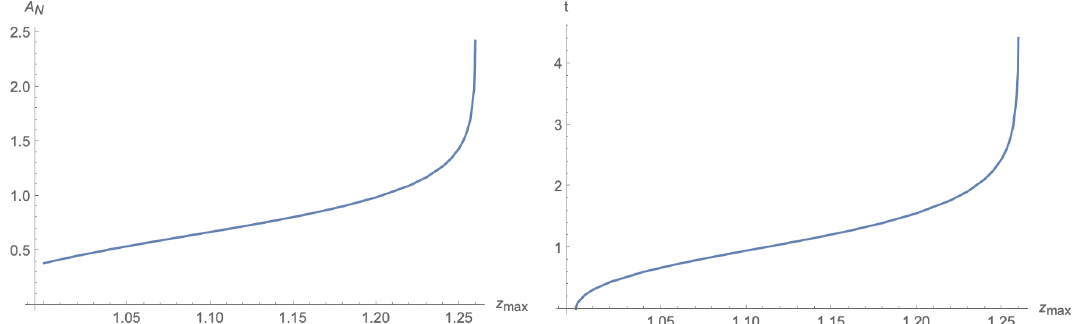
Figure 19 . Left: function A N ( z max ) ; right: function t ( z max ) . The figures show that A N and t increase with z max . The right figure shows that z max = 1 corresponds to t = 0 and z max = 2 1 d − 1 ≈ 1 . 260 corresponds to t → ∞ .